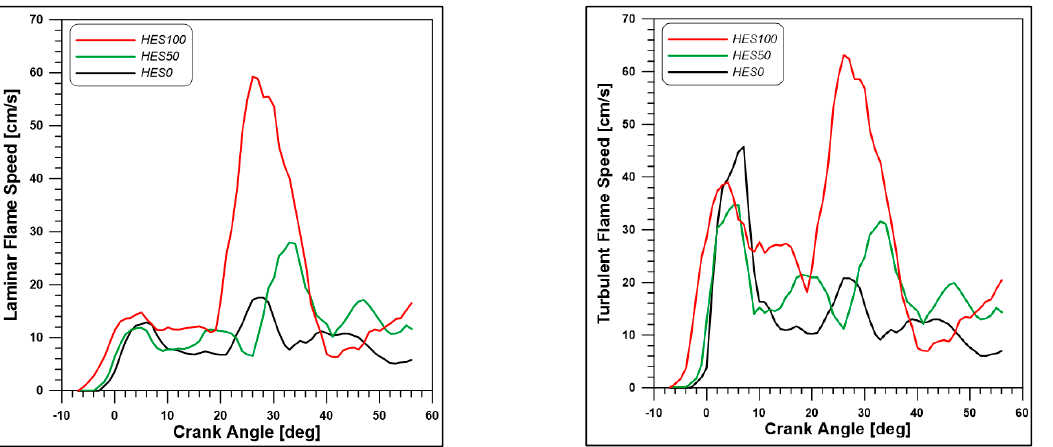
Figure 26. Laminar and turbulent flame speeds .